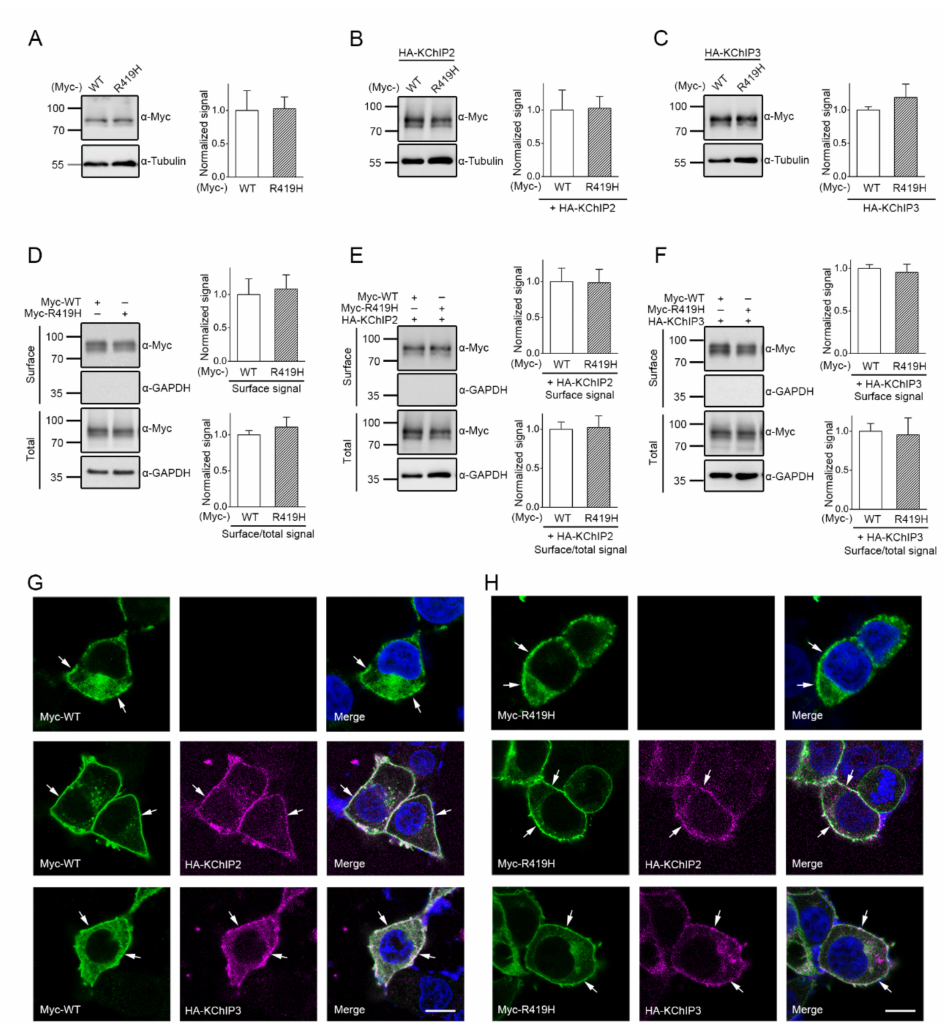
Figure 3. Biochemical and immunofluorescence characterizations of human K V 4.3 WT and the p.R419H variant. Myc-K V 4.3 subunits were expressed in HEK293T cells in the absence or presence of auxiliary HA-KChIP2 and -KChIP3 subunits. ( A – C ) ( Left panels ) Representative immunoblots. Proteins were detected with anti-Myc ( α -Myc) and anti-tubulin ( α -Tubulin) antibodies. Molecular weight markers (in kDa) are labeled to the left. ( Right panels ) Quantitative analyses indicating comparable protein level of the WT and the p.R419H K V 4.3. Total K V 4.3 protein density was standardized with cog- nate tubulin level, followed by normalization with respect to the WT ( n = 4–6). ( D – F ) Surface biotinylation analyses for Myc-K V 4.3 subunits in the absence ( D ) or presence of auxiliary HA-KChIP2 ( E ) and -KChIP3 ( F ) subunits. Representa- tive immunoblots and quantitative analyses for the surface signals are shown at the left and right panels, respectively ( n = 4). The surface/total ratio corresponds to membrane trafficking efficiency. ( G , H ) Representative immunofluorescence images demonstrating similar subcellular localization pattern of K V 4.3 WT and p.R419H ( green ) in the absence ( top panels ) or presence of KChIP2 ( middle panels ) and KChIP3 ( bottom panels ) ( magenta ). Cell nuclei were counterstained with DAPI ( blue ). Arrows denote membrane localization. Merged images are shown in the right panels. Scale bar: 10 µ